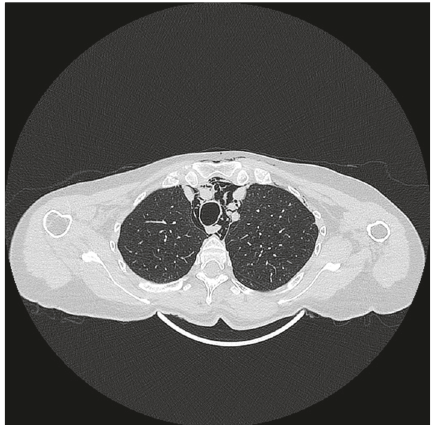
Figure 4: Computed tomographic axial view of the emphysema descending to the mediastinum, where it is evident mainly in the anterior region of perivascular adiposity and surrounding the trachea and oesophagus